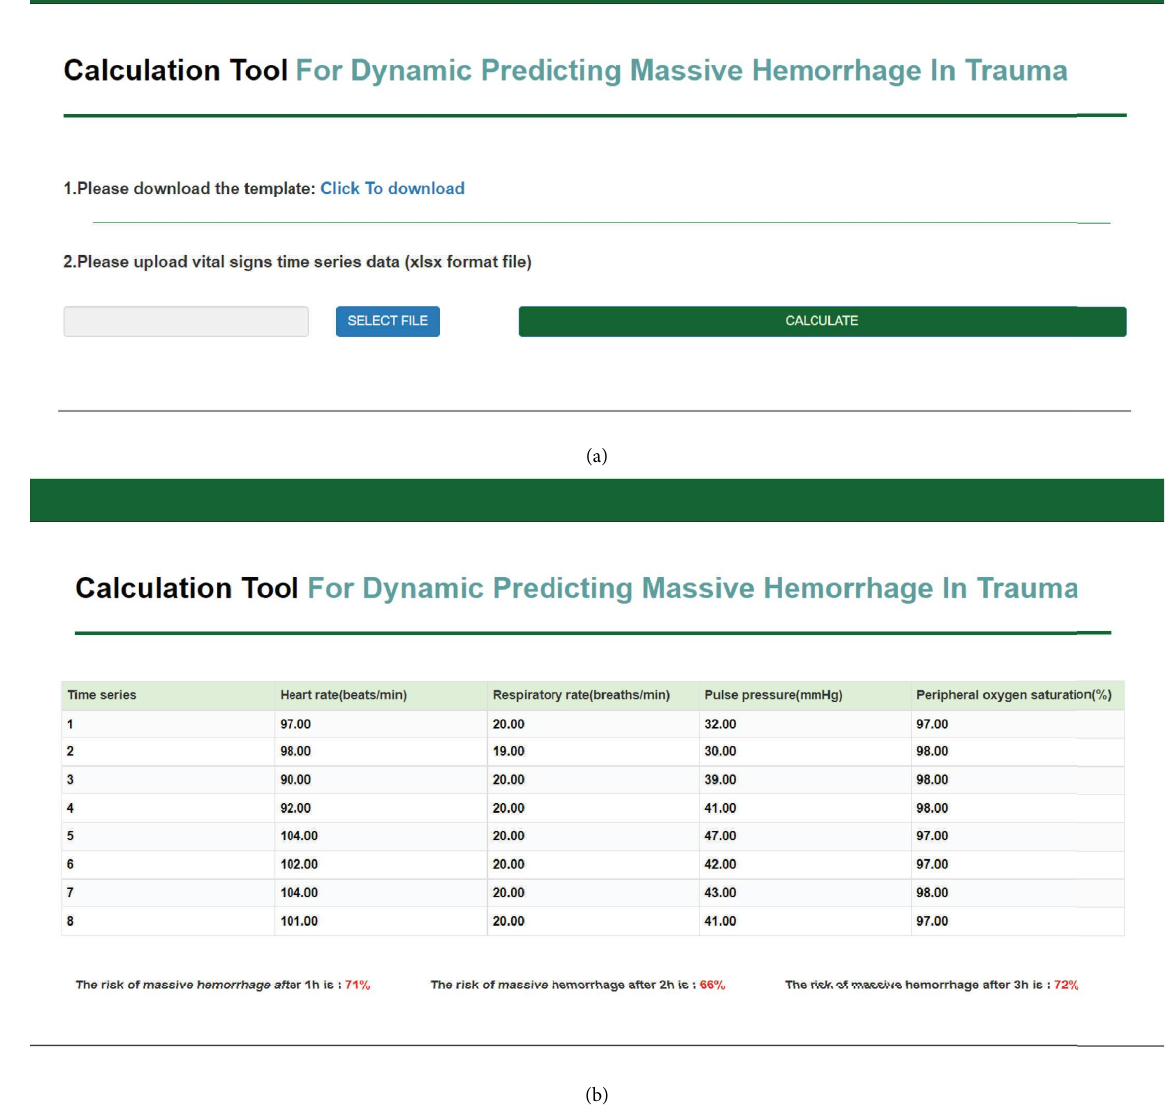
Figure 3: Te web calculator for the dynamic prediction models for a future massive hemorrhage in trauma. (a) Data entry page; (b) forecast results page. Click the ‘Click to download’ link in Figure 3(a) to download the excel template, import the vital signs time-series data according to the template format, click the ‘SELECT FILE’ button to select the fle to be uploaded, and fnally, click the “CALCULATE” button for risk prediction. Te imported vital signs time-series data are shown at the top of Figure 3(b), and the prediction probability of massive hemorrhage in trauma in the future 1, 2, and 3 hours is shown below, in the range of [0, 1]. Te higher the value, the greater the risk of massive